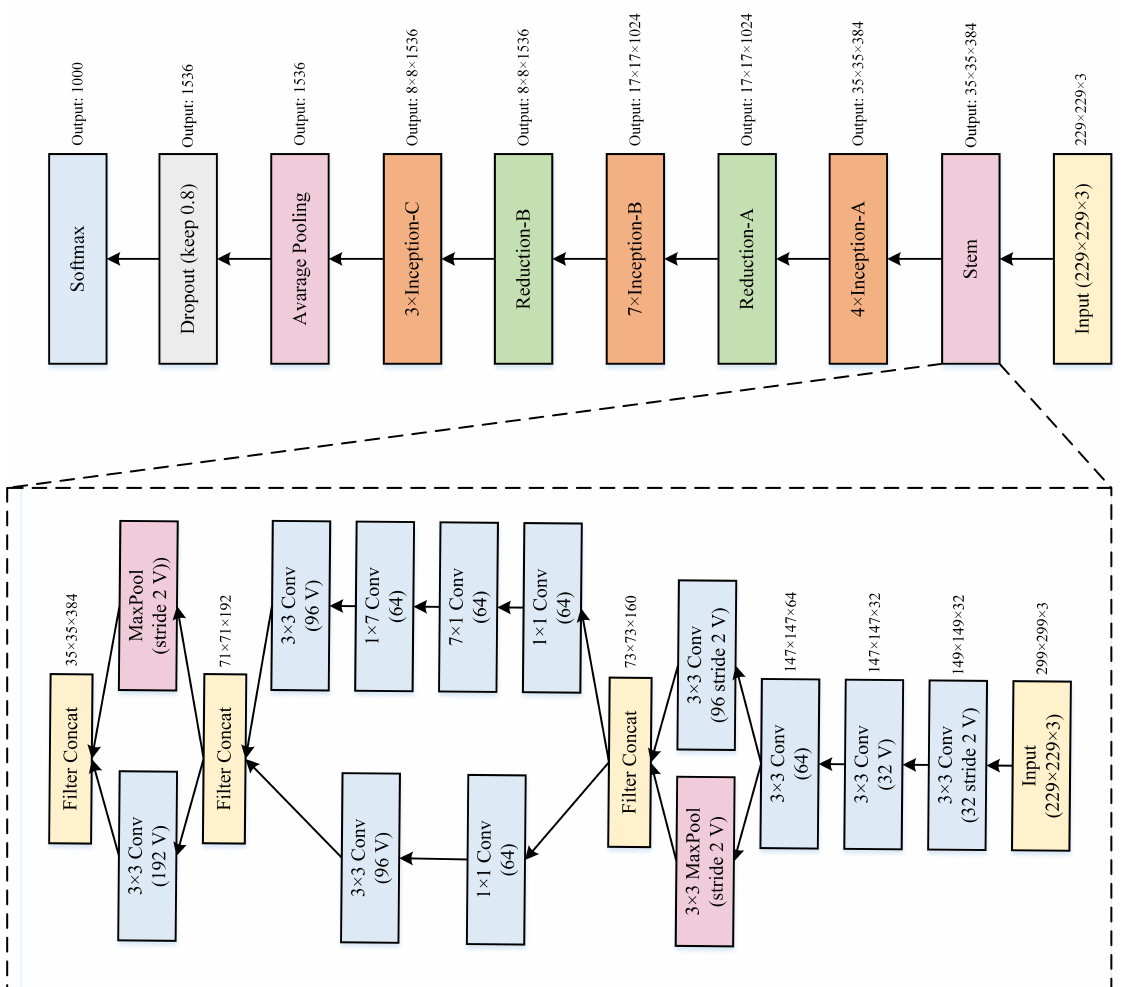
Figure 14. Overall Architecture of InceptionV4. The upper part of the picture is the overall structure, the lower part of the picture is the Stem of the